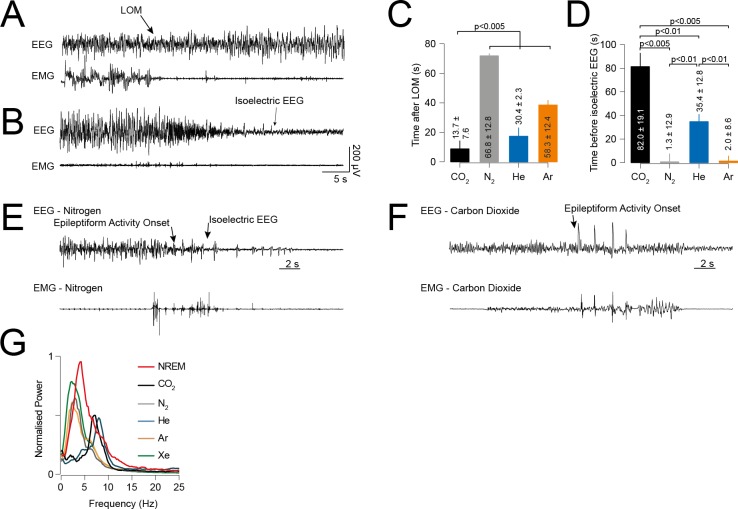
Timing of epileptiform event onset.(A) Representative EEG/EMG trace showing the criteria for determining LOM. Note the change in EEG from a low amplitude fast (awake) pattern to high amplitude slower rhythm. Note also that changes in EMG activity (LOM) occur several seconds before EEG activity changes. (B) Representative example from Xe recording (i.e.: no epileptiform activity) of the criteria for cessation of neocortical activity: defined as the point of onset of consolidated isoelectric EEG. (C) Time delay from LOM to epileptiform activity onset. Epileptiform events from CO2 occurred soon after cessation of neocortical activity. There was a significant delay for other gases, with He induced epileptiform activity occurring latest. (D) Time of epileptiform activity onset before cessation of neocortical activity. N2 and Ar epileptiform activity occurred at the point of cessation of neocortical activity. (E), (F) Representative EEG/EMG traces of the onset of epileptiform activity and cessation of neocortical activity for N2 and CO2 respectively. Note the EMG tone occurring after cessation of neocortical activity, which indicates the continued activity of spinal and brainstem reflexes. (G) Normalised power spectra of EEG for 15s after LOM and also natural sleep (NREM). CO2 and He resulted in brain activation whereas other gases reduced cortical arousal compared to sleep.